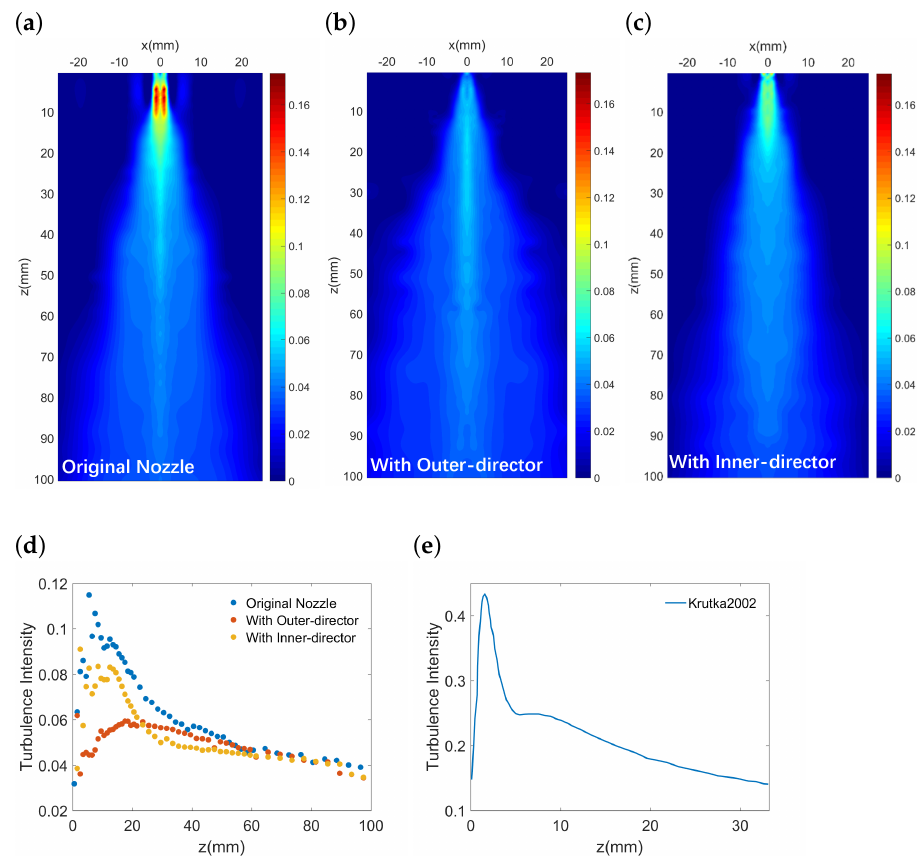
Figure 6. ( a ) Distribution plot of turbulence intensity under original nozzle. ( b ) Distribution plot of turbulence intensity under nozzle with outer-director. ( c ) Distribution plot of turbulence intensity under nozzle with inner-director. ( d ) Centreline turbulence intensity, and ( e ) Calculated centreline turbulence intensity in literature123 [12] (for